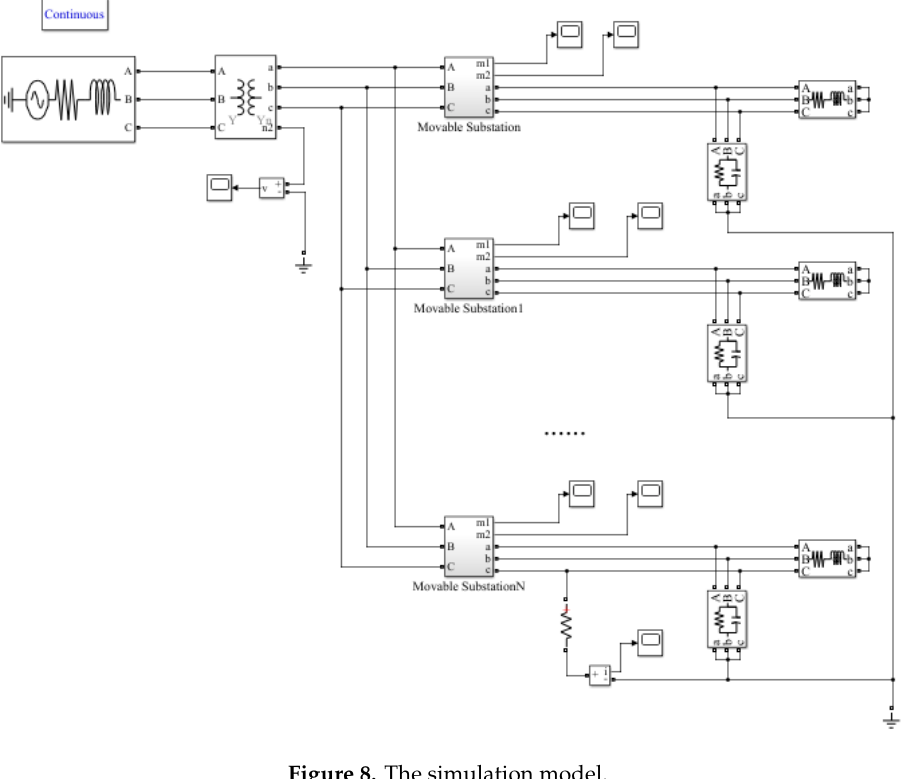
Figure 8. The simulation model.